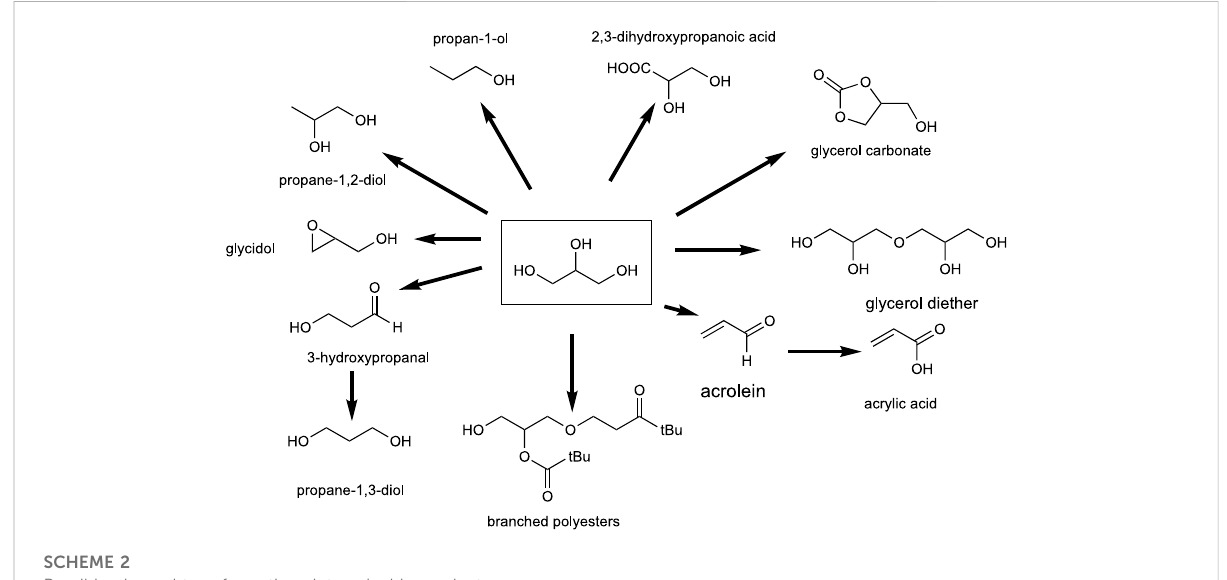
SCHEME 2 Possible glycerol transformations into valuable products.